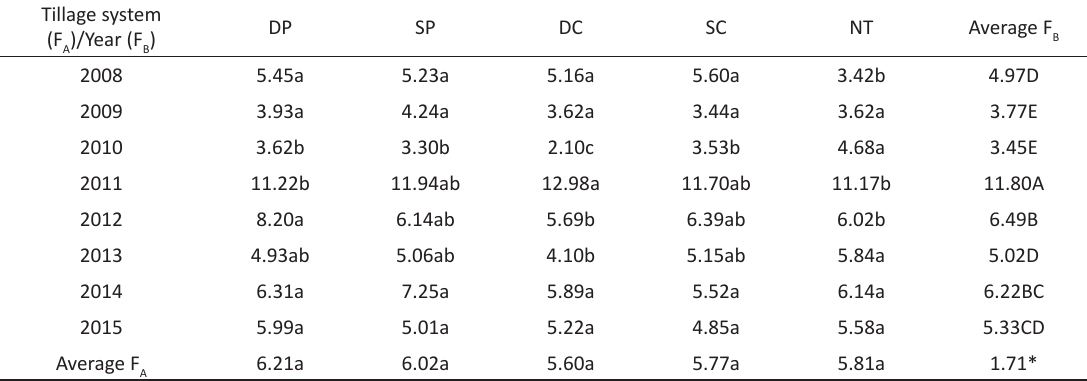
Table 9. The impact of the tillage systems on the grain yield (Mg ha -1 ) Tillage system